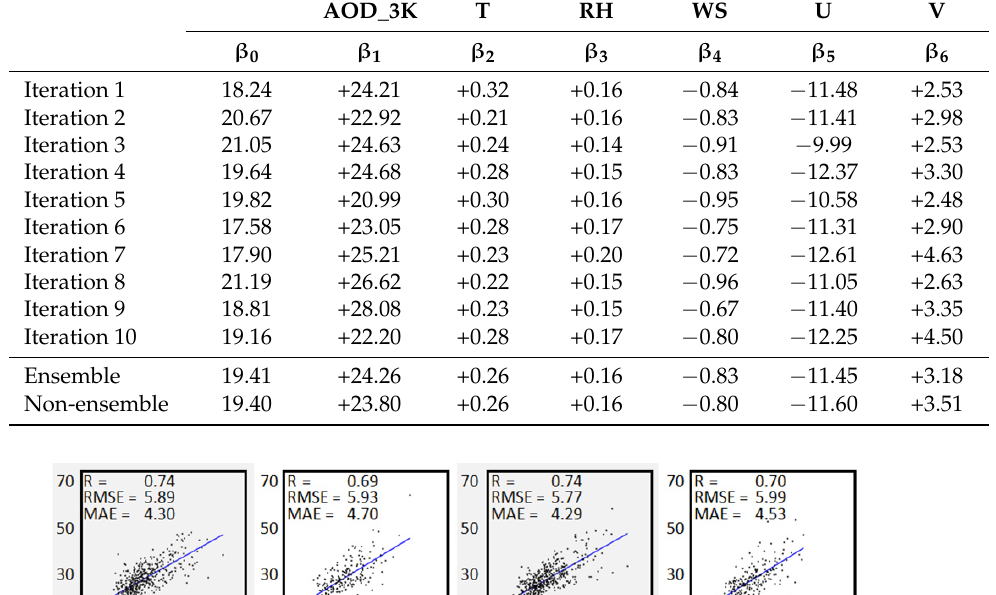
datasets ranged between 0.04 and 0.06. The differences in RMSE ranged from − 1.18 μ g m − 3